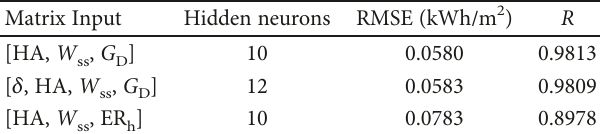
Table 1: Best learning ’ s performances with G